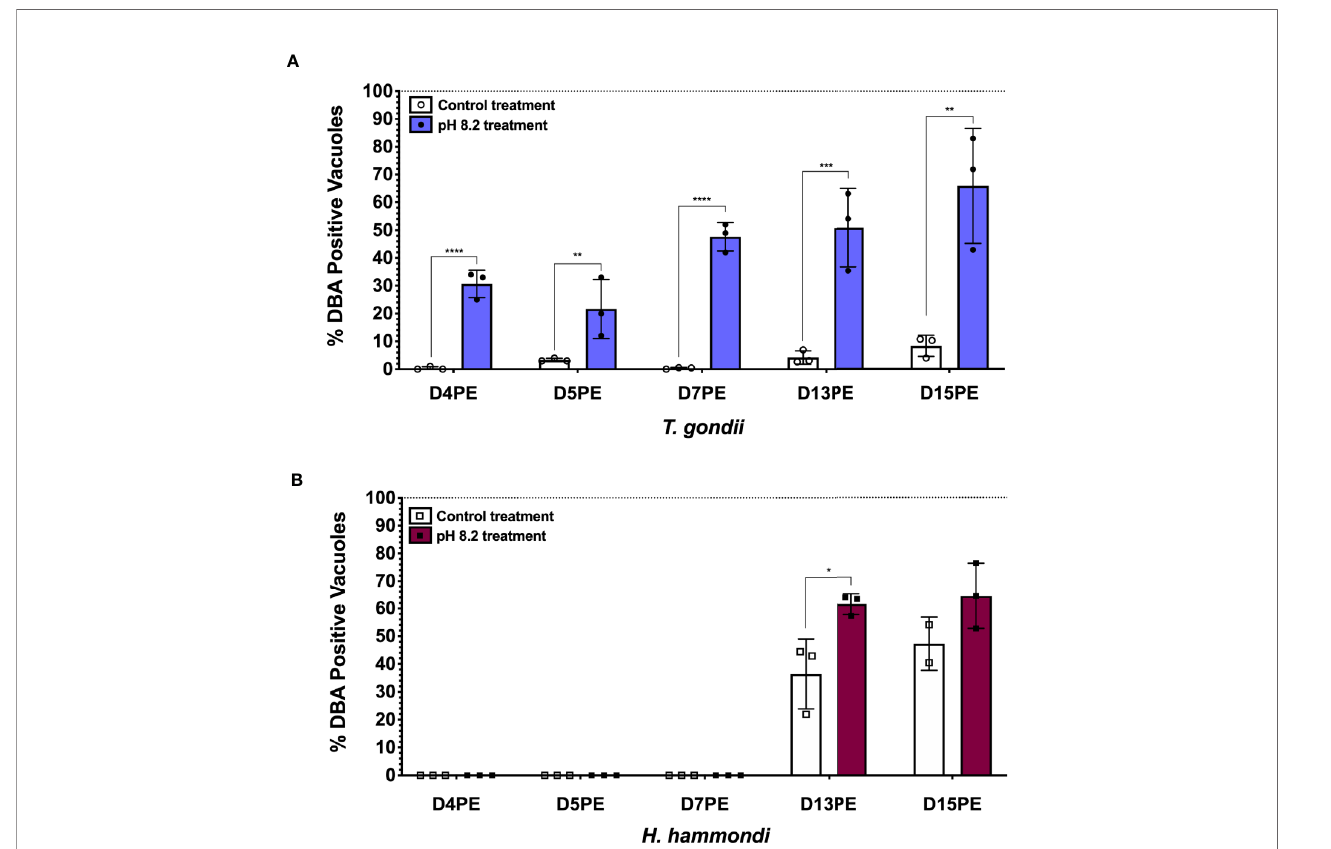
FIGURE 2 | H. hammondi can respond to stress conditions when exposed to alkaline pH 13 days post excystation (DPE) from oocysts. (A) Percentage of DBA positive vacuoles observed following 48 h of alkaline pH stress initially applied at D4, 5, 7, 13, and 15PE for T. gondii VEG. (B) Percentage of DBA positive vacuoles observed following 48 h of alkaline pH stress initially applied at D4, 5, 7, 13, and 15PE for H. hammondi American. Statistical signi fi cance was determined by 2way ANOVA with Sidak ’ s multiple comparisons test of arcsine transformed data. (N = 2 – 3 biological replicates, *P = 0.03, **P < 0.01, ***P < 0.001, and ****P < 0.0001) This experiment, with the exception of time of alkaline stress application at the time points mentioned above, was performed as previously described (Sokol et al.,